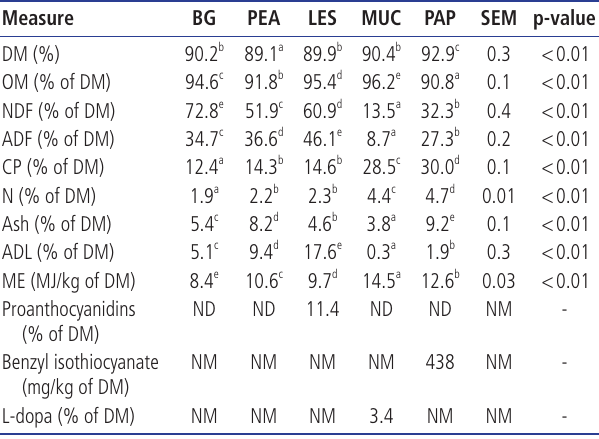
Table 1. Chemical composition of the bahiagrass (BG), perennial peanut (PEA), sericea lespedeza (LES) hays, mucuna (MUC), and papaya (PAP) seeds fed to goats (n = 7) Measure